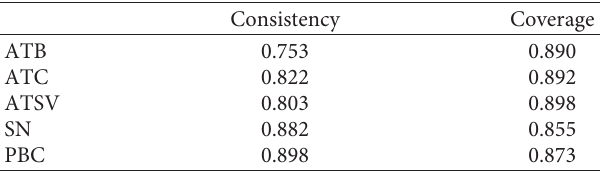
Table 7: Analysis of necessary conditions.